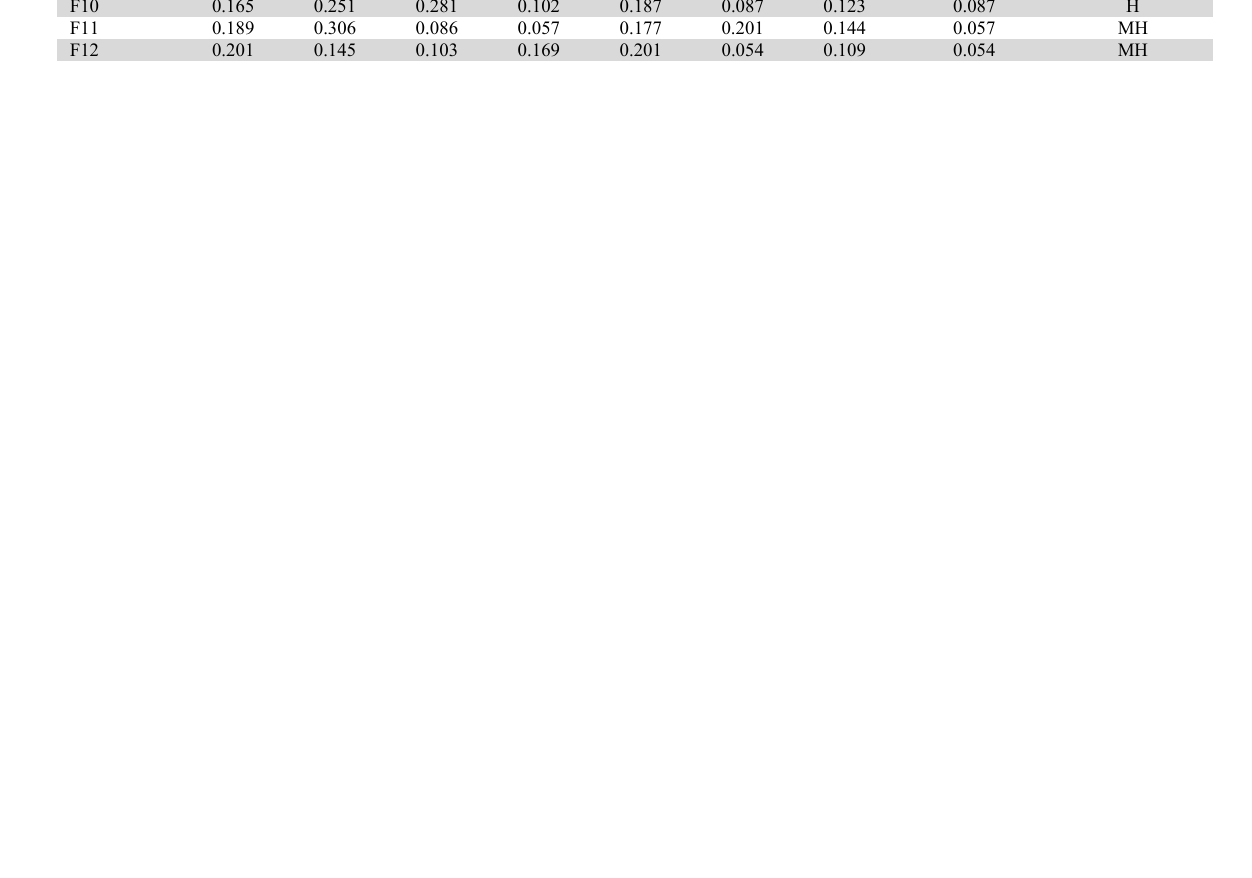
The linguistic terms correlate with the average fuzzy scores for the environmental factors Factors Distance between linguistic terms and factors Minimum